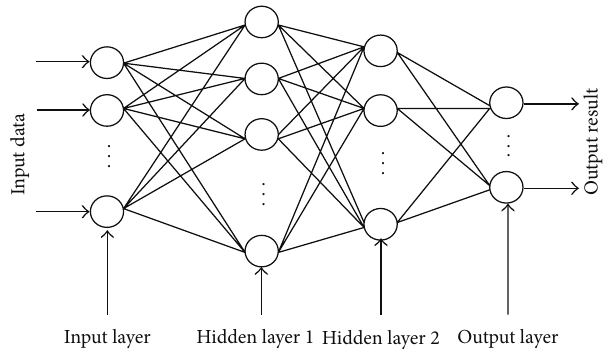
Figure 7: Simplified model of BP neural network.